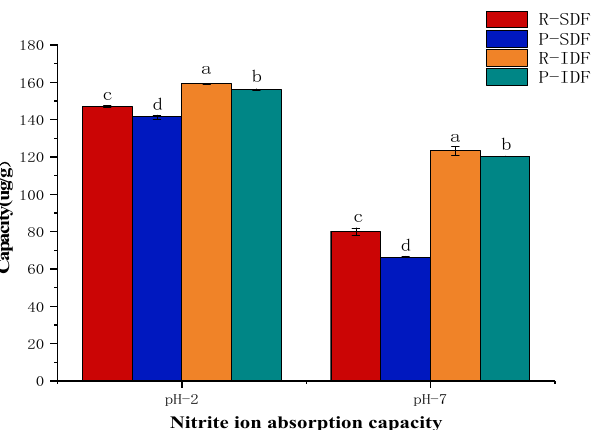
Figure 5. The NIAC of R-IDF, P-IDF, R-SDF, P-SDF. R-SDF represents the residue soluble fiber; P-SDF represents the peel soluble fiber; R-IDF represents the residue insoluble fiber; P-IDF represents the peel insoluble fiber; values with different letters (a, b, c, d) for IDF or SDF are significantly different ( p < 0.05).